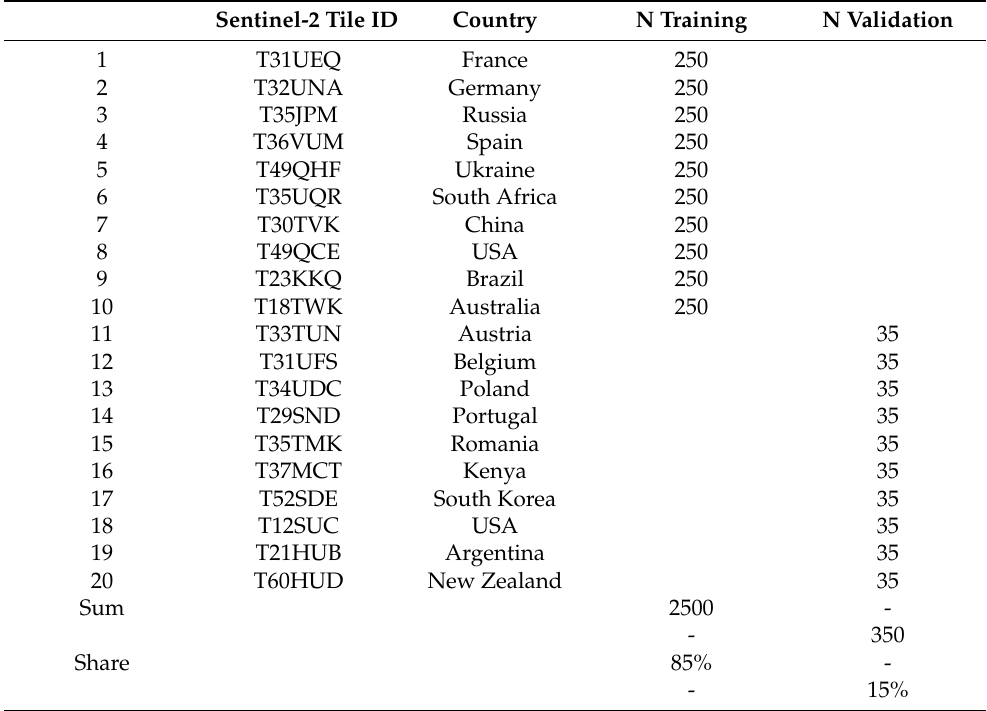
Figure A2. RF confusion matrix on the pixel level based on the subset of the labelled data. Table A1. Sentinel-2 tiles and number (N) of labelled boxes.